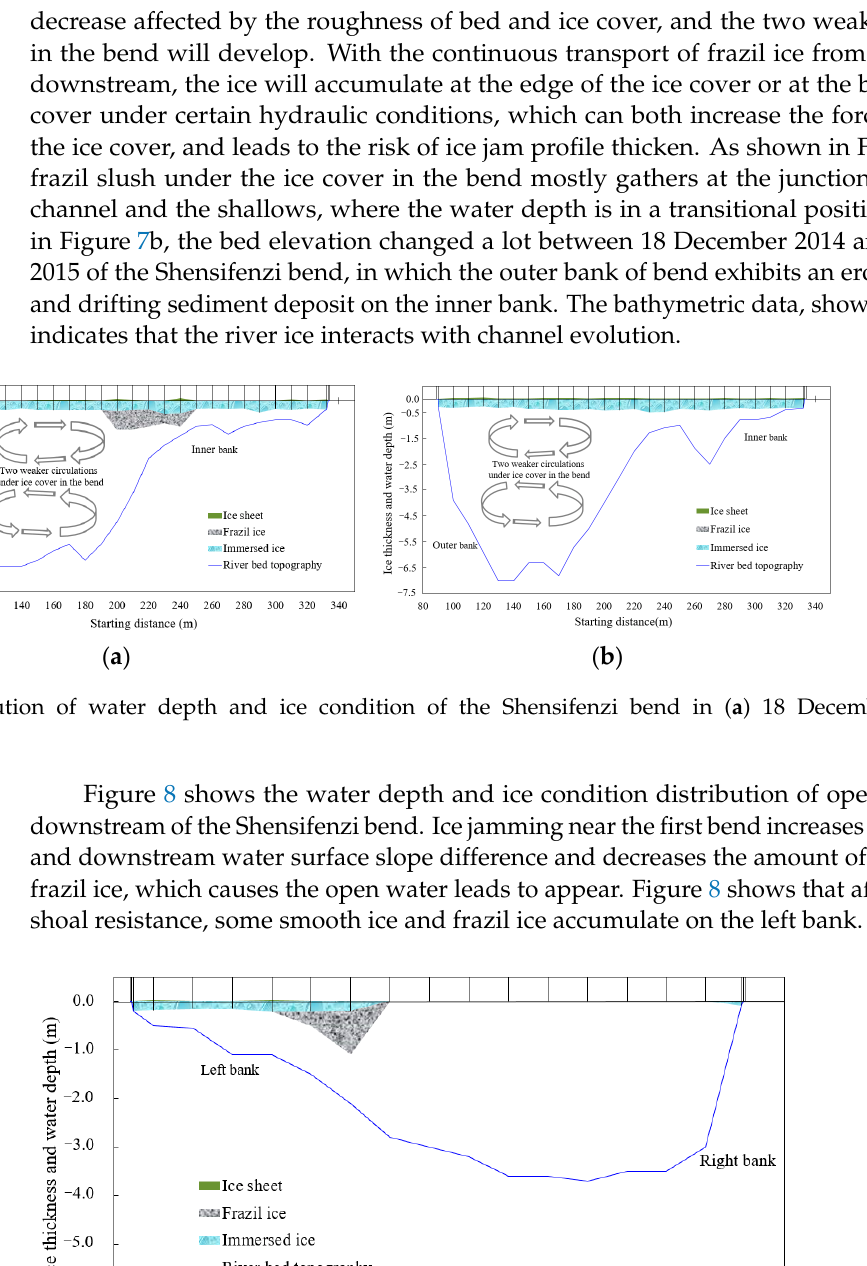
Figure 6. The bed elevation of the Shensifenzi bend.